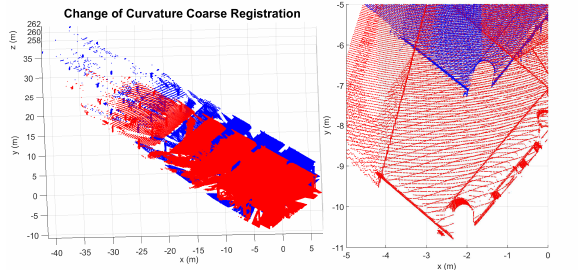
Table 4. RMSE values (in mm) obtained from fine registration